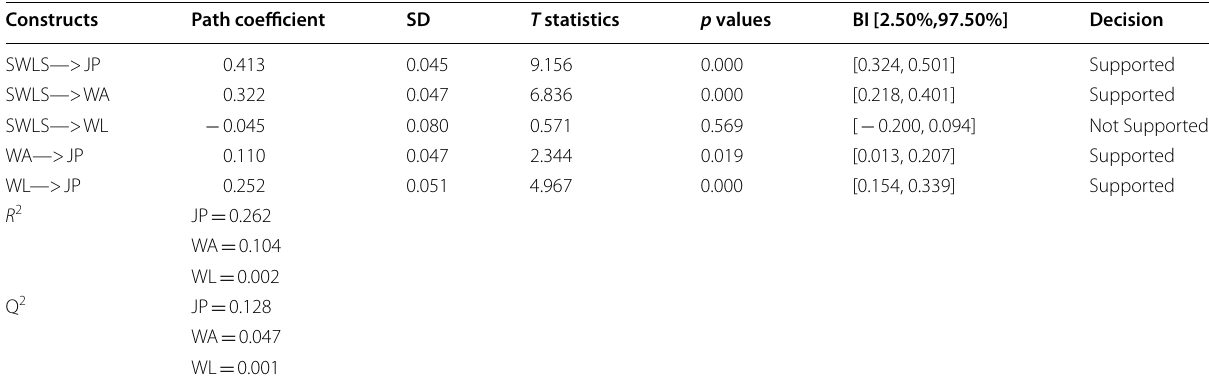
Table 5 Testing the direct